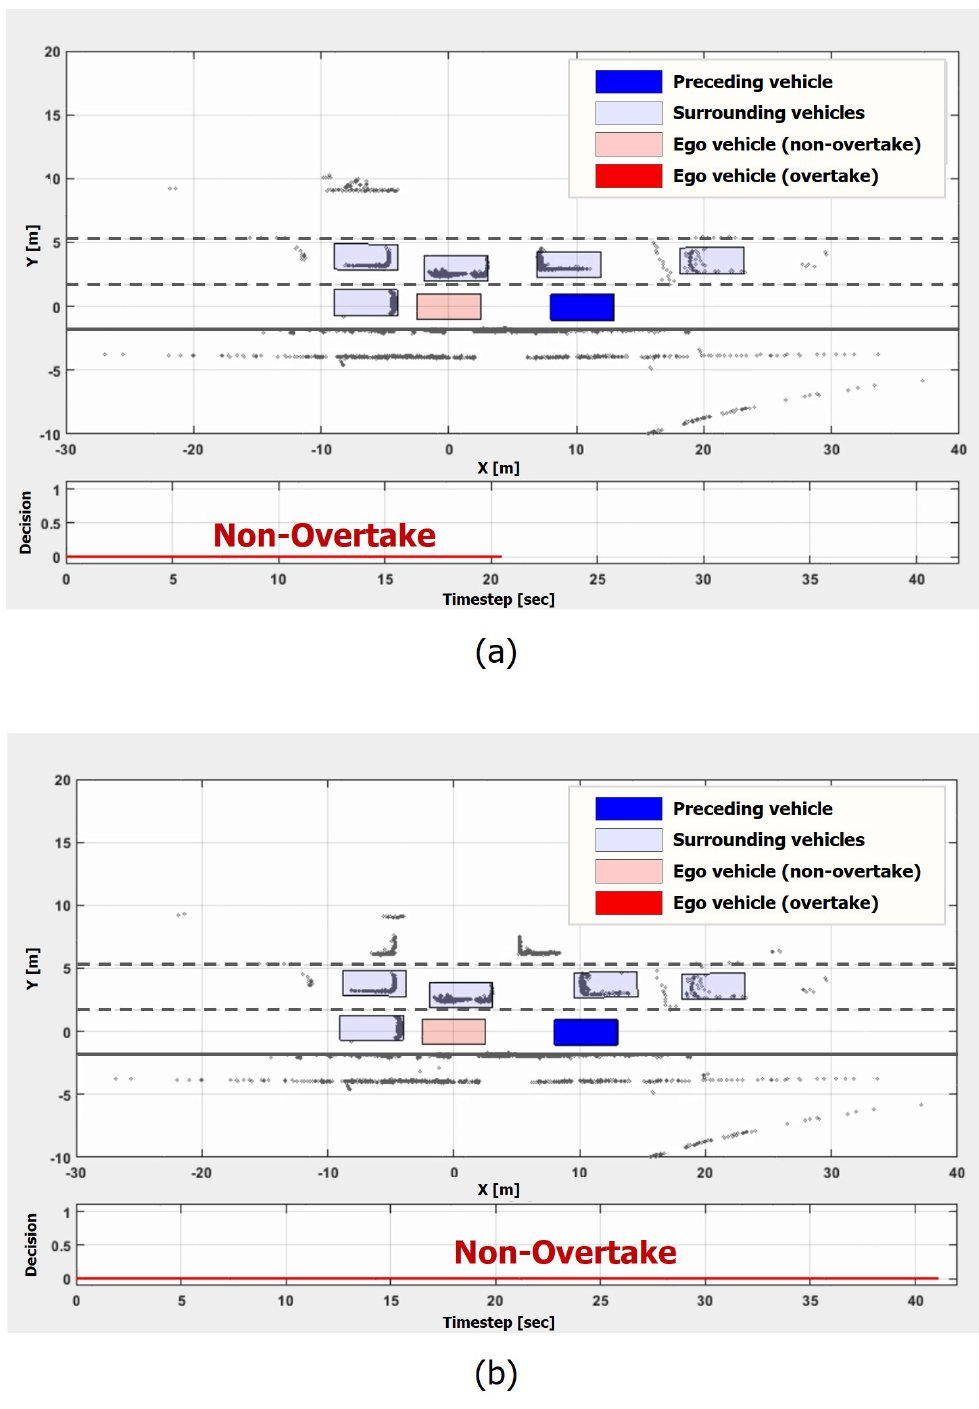
Figure 14. Traffic jam scenario. In the scenario, the ego vehicle is stuck in the middle of traffic where many vehicles are either stationary or moving extremely slowly: ( a ) t = 21 s; ( b ) t = 41